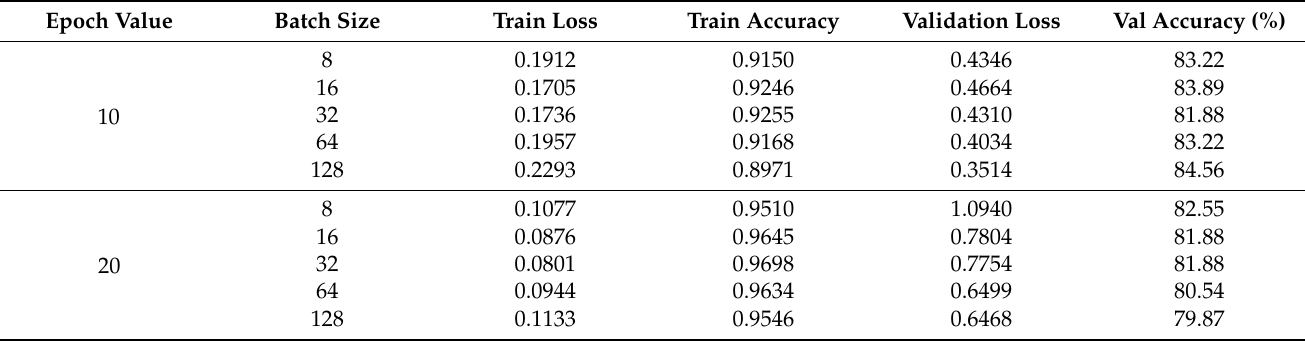
Table 6. Training Performance of Modified Vgg16 Model with Adam